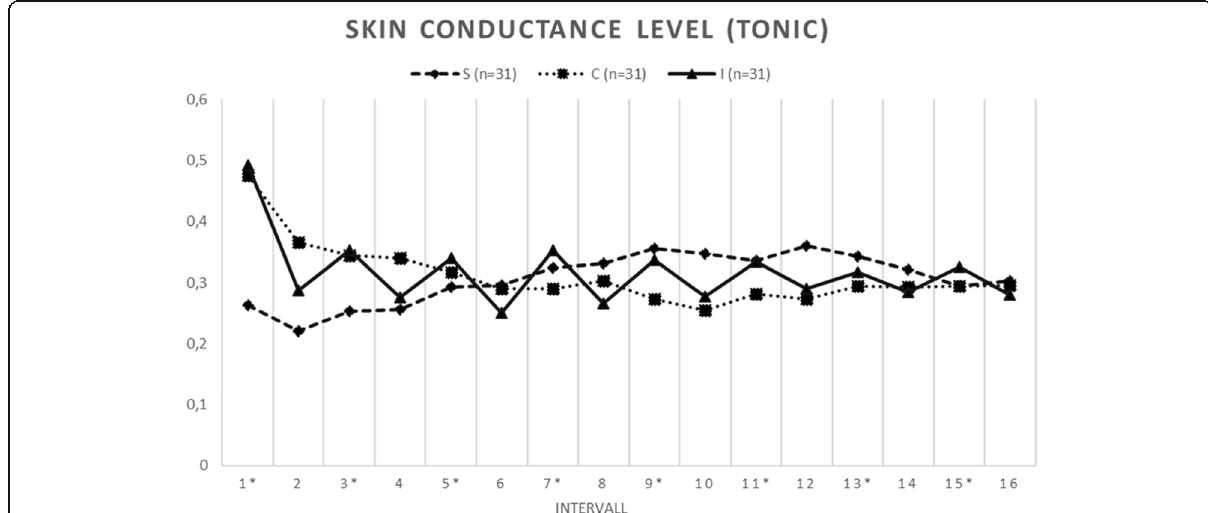
Fig. 6 Trend of tonic skin conductance across all